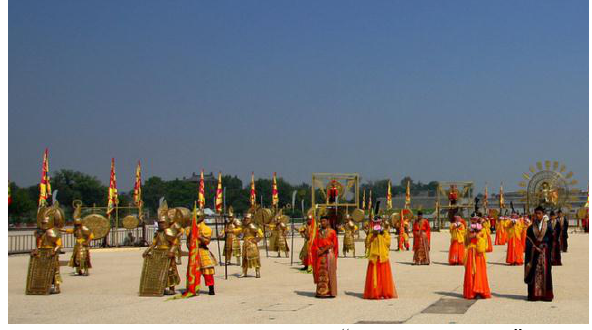
Figure 8. live performance – “ dan feng ying bin